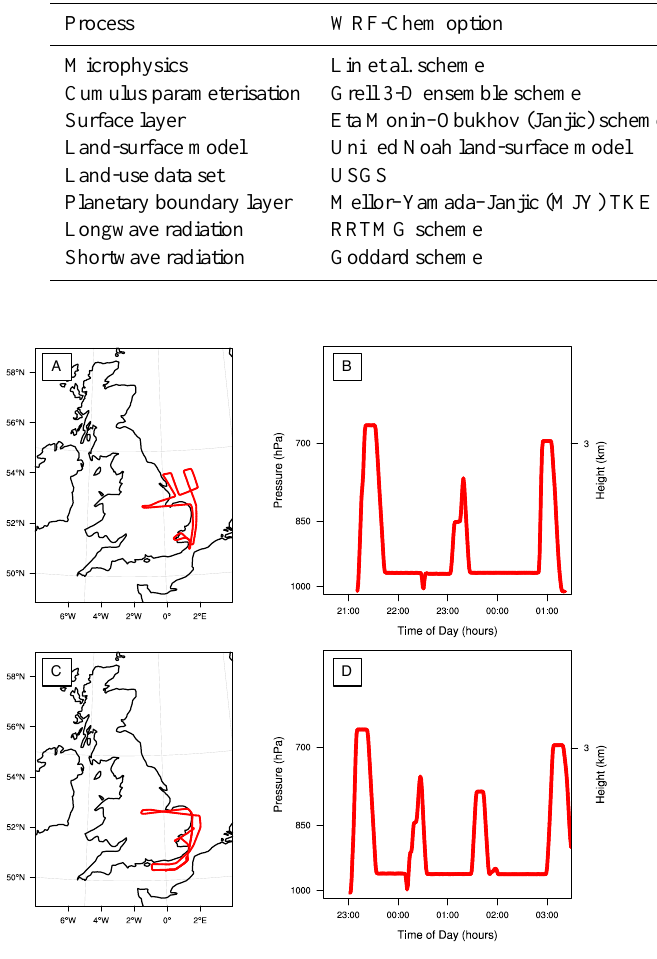
Figure 2. B535 and B541 flight paths ( a and c , respectively) and vertical profiles ( b and d ,